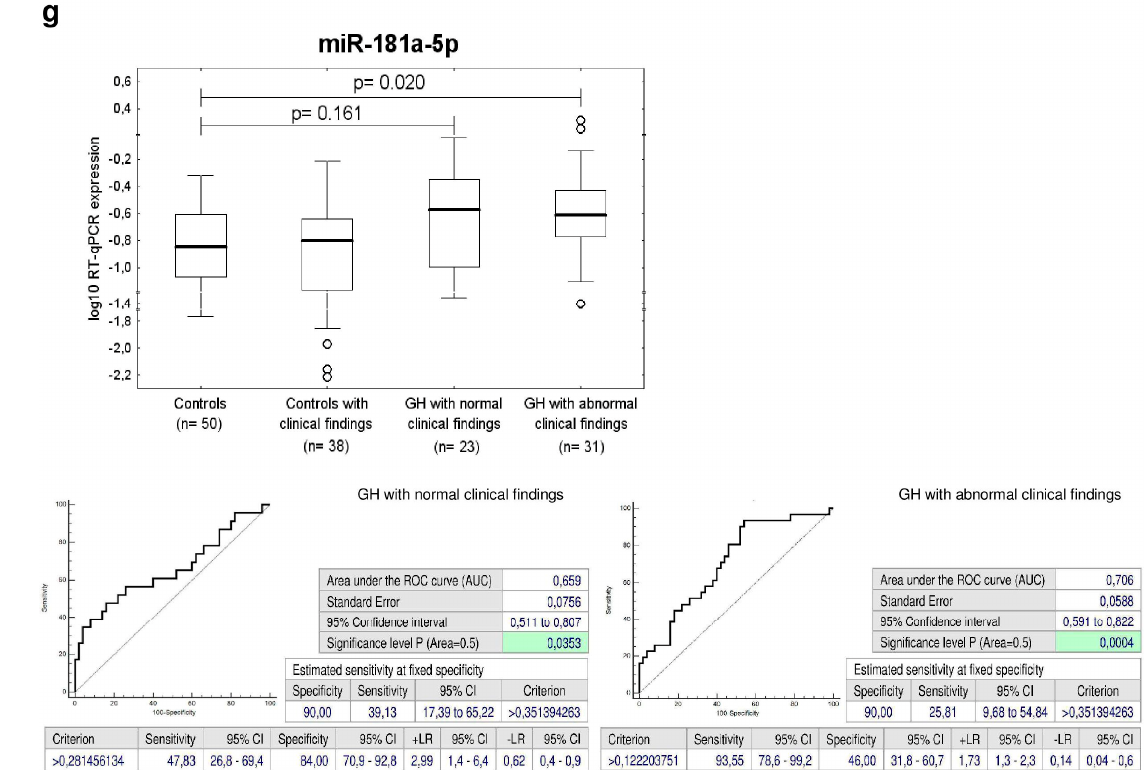
Figure 6. Postnatal microRNA expression profile in children descending from GH pregnancies irrespective of postnatal clinical findings. ( a – g ) Increased expression of miR-1-3p, miR-17-5p, miR-29a-3p, miR-126-3p, miR-133a-3p, miR-146a-5p, and miR-181a-5p was observed in children descending from GH pregnancies with normal or abnormal postnatal clinical findings. The ROC curve analysis showed the difference in microRNA gene expression between the controls and the group of children exposed to GH with postnatal normal clinical findings or children with a prior exposure to GH that already developed any cardiovascular complication (valve problems and heart defects) or were identified to be overweight/obese and/or prehypertensive/hypertensive.